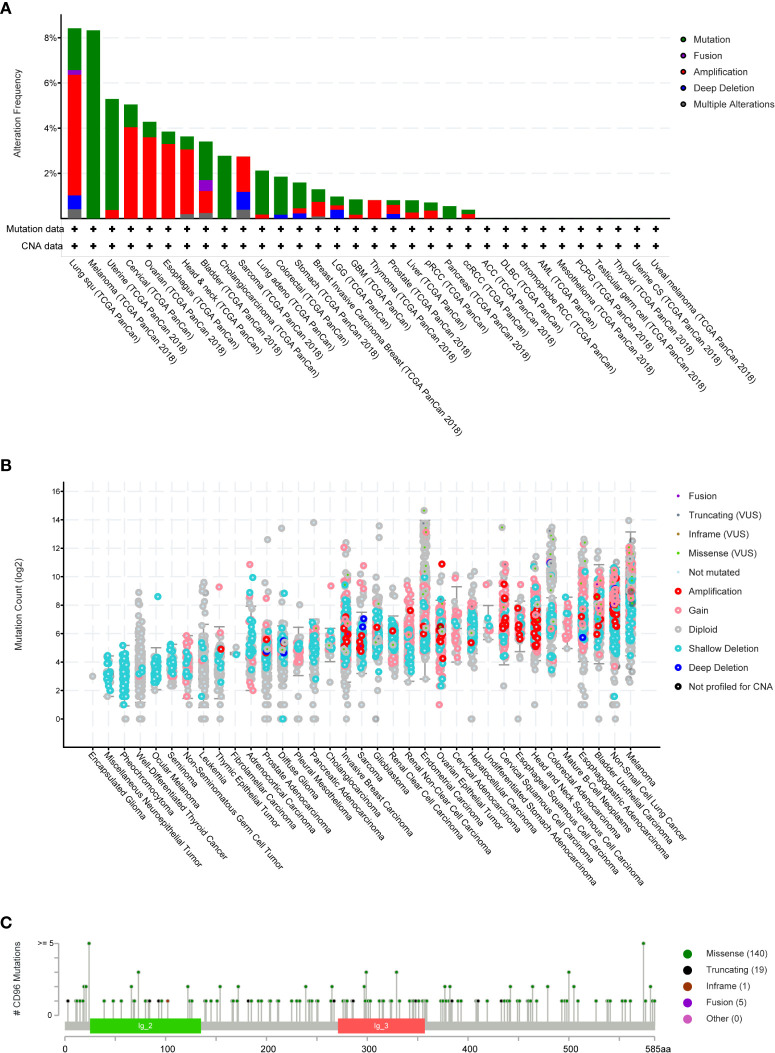
CD96 mutation landscape. (A) CD96 mutation frequency in multiple TCGA pan-cancer studies according to the cBioPortal database. (B) The general mutation count of CD96 in various TCGA cancer types by the cBioPortal database. (C) Mutation diagram of CD96 in different cancer types across protein domains.